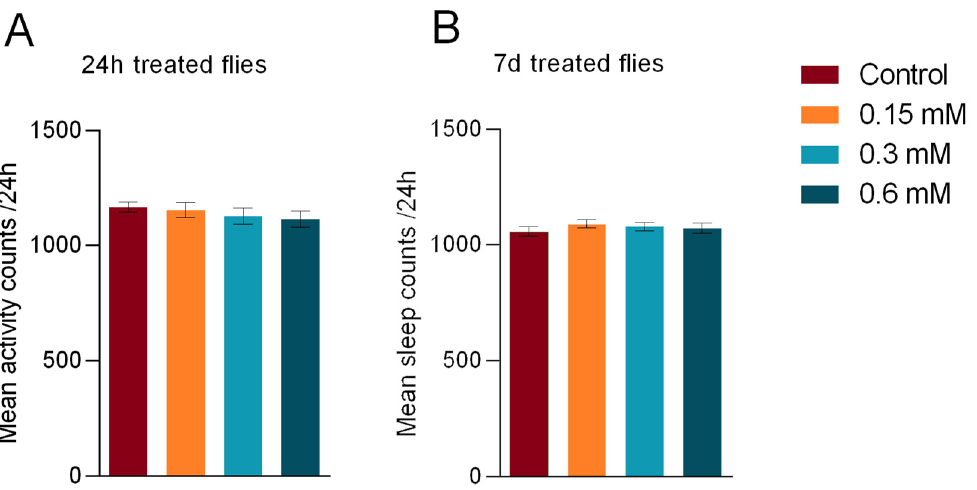
Figure 3. NMDA-inhibition effects on daily sleep time. ( A ) Despite inducing increased activity, 24 h MK-801 treatment was unable to evoke significant changes in average daily sleep counts, independent of concentration. ( B ) Similarly, 7 d intake of MK-801 at the tested concentrations did not alter sleep. Sample sizes are the same as those described in Figure 2. One-way ANOVA with linear trend post hoc was applied for statistical calculations, resulting in p > 0.05 for all comparisons. Values are shown as mean ± SEM.